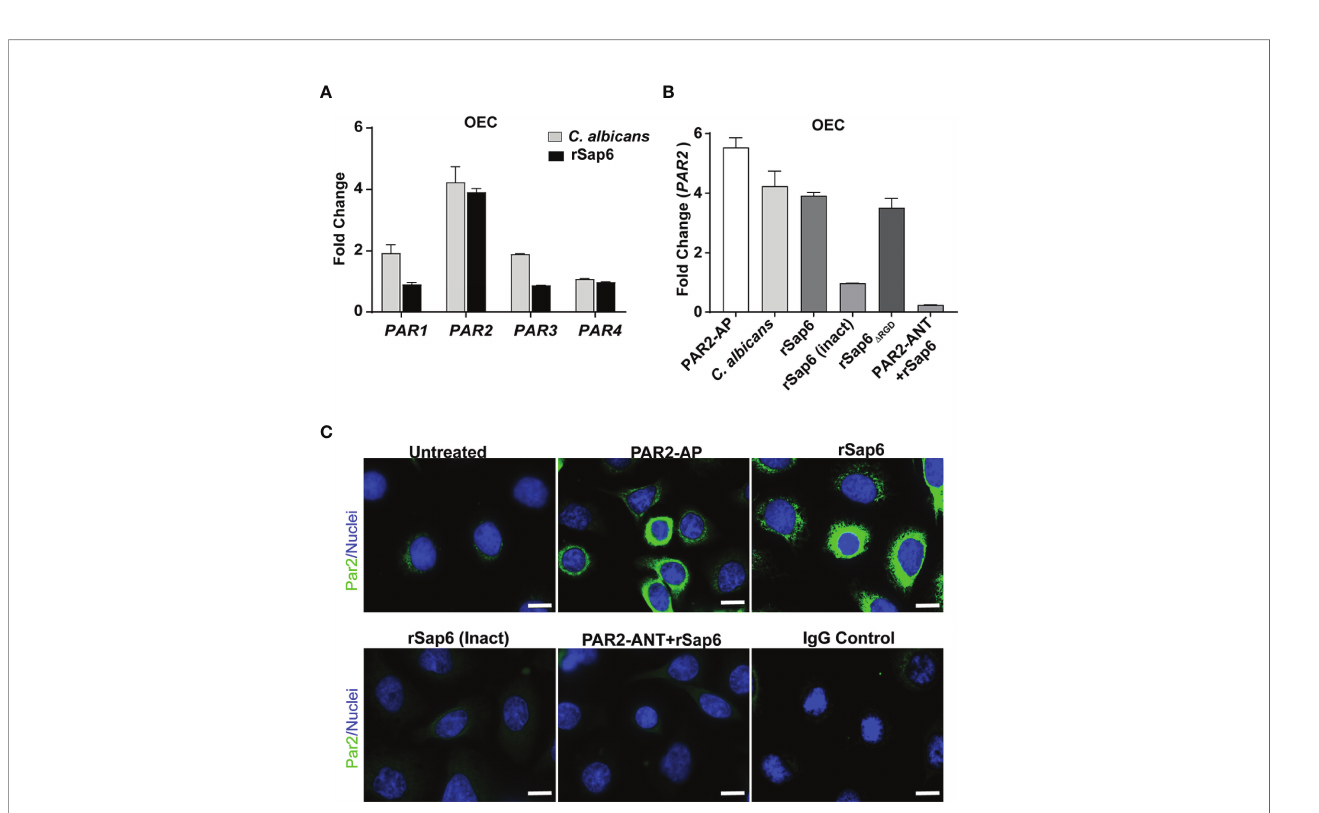
FIGURE 4 | Sap6 primarily induces PAR2 expression in OECs. (A) Changes in gene expression of PAR1-4 genes in human OECs were calculated by RTqPCR following C albicans (5 X 10 6 cells/ml) or rSap6 (10µM) stimulation. C albicans increased expression of OEC PAR2 (4-fold), PAR1 (2-fold) and PAR3 (2-fold) while PAR4 remained unchanged (grey bars), while rSap6 increased PAR2 expression levels by 4-fold, and failed to induce expression levels of PAR1 , PAR3 or PAR4 (black bars). GAPDH was used as a housekeeping gene. (B) Changes in expression levels of PAR2 in OECs following 24 h stimulation with C albicans , rsap6, rSap6 (Inact) or PAR2-ANT+rSap6 were calculated by RTqPCR. PAR2-AP induced a 5.8-fold increase in OEC PAR2 expression, similar to that induced by C albicans cells, rSap6 or rSap6 D RGD . However, rSap6 (Inact) and pre-incubation with a PAR2 antagonist (PAR2-ANT) before addition of rSap6 abolished the increase in PAR2 expression. (C) Cell surface localization of PAR2 (green) was detected using immuno fl uorescent microscopy following staining of OECs with polyclonal rabbit anti- PAR2 antibody and Alexa Fluor 488-conjugated anti-rabbit antibody. OECs treated with PAR2-AP or rSap6 showed increased level of cell surface localization of PAR2 compared to untreated control cells, while treatment with rSap6 (Inact) or PAR2-ANT did not increase cell surface localization of PAR2. IgG was used as a negative control. Nuclei (blue) were stained with Hoechst. Scale bar shown is 10 µm.